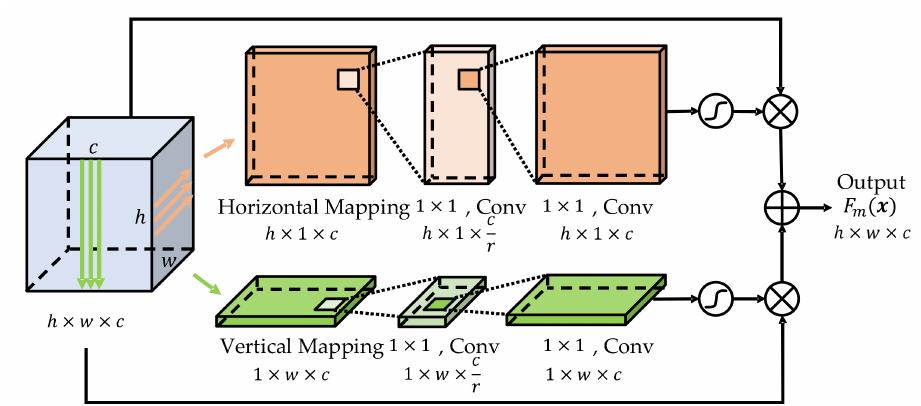
Figure 9. Structure of the feature-map-specific direction mapping